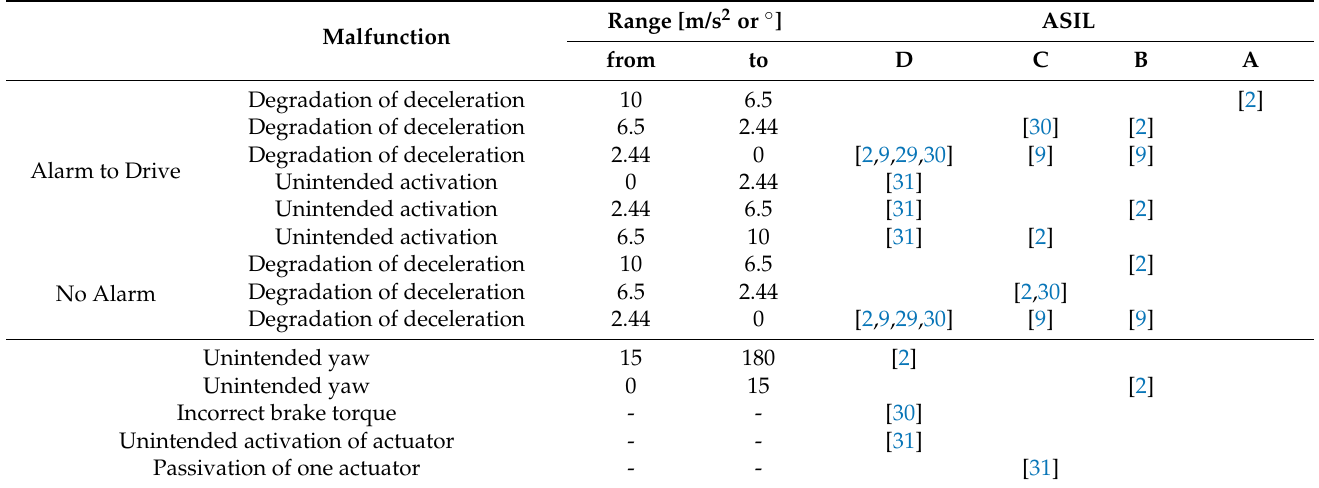
Table 5. ASIL classifications of malfunctions of service braking